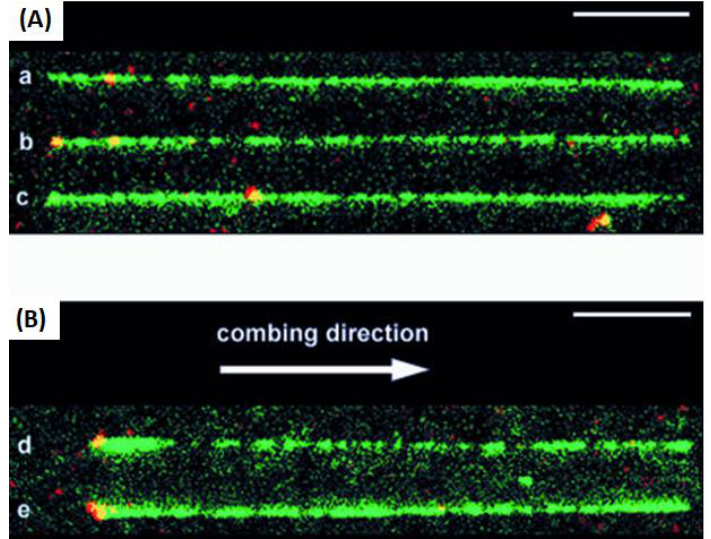
Figure 8. Visualization of labels on combed lambda molecules. DNA was stained with YOYO-1 (green). The labeled DNA fragments contained Alexa Fluor 546 (red); they therefore appear as yellow spots. The bars represent 5 mm. A montage of different patterns of combing and labeling was produced: ( A ) aligned longer (26 ± 27.5 mm) molecules. The combed molecules were aligned so that the red internal labels were located on the left side, but they were equally distributed on both sides with respect to the combing direction (see text). ( B ) Aligned shorter molecules (23.5 ± 25.5 mm). In this case, combed molecules were oriented with respect to the combing direction; i.e., the left side is the side where the DNA molecule sticks ® rst to the glass surface before being stretched in the direction indicated by the arrow. Reprinted with permission from ref. [60]. Copyright 2003, Oxford University